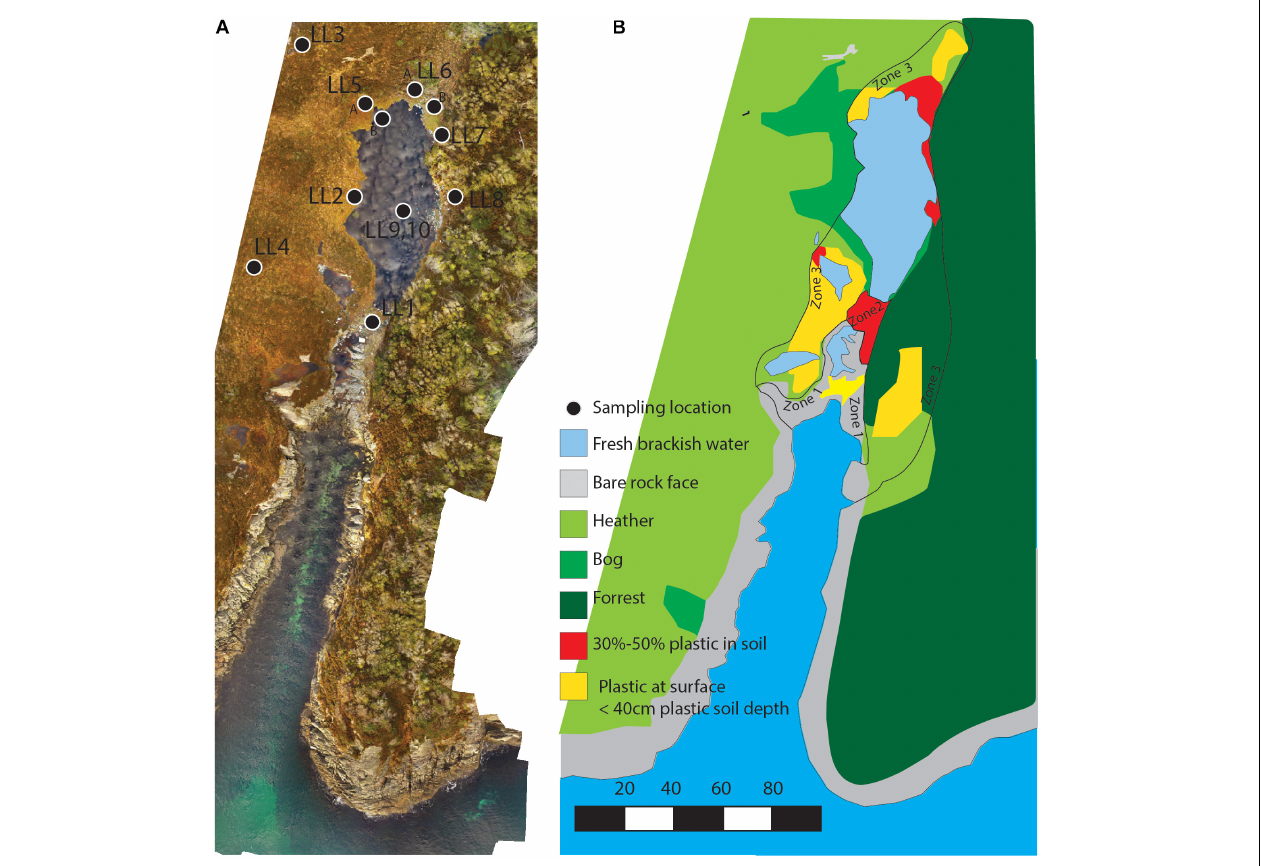
FIGURE 4 | Map showing the plastic pollution in Lisle Lyngøyna and typical vegetation types. (A) Drone orthomosaic. (B) Map based on field work and image interpretation.